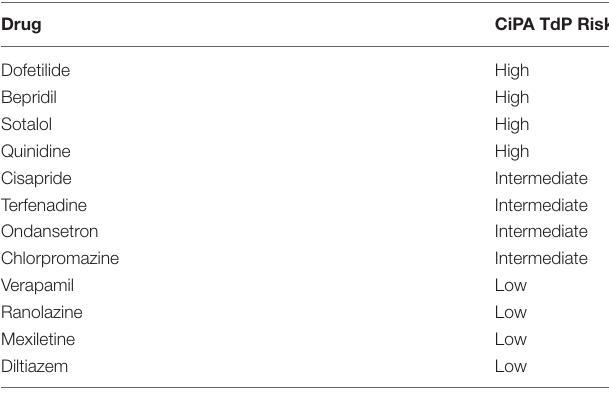
TABLE 1 | TdP risk levels for the 12 CiPA training compounds.